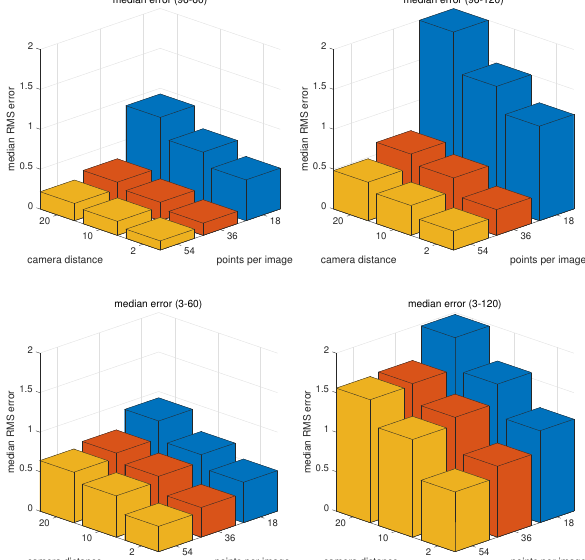
Figure 4. Median RMS error of AGPA as a function of cam- era distance d and number of tie-points visible in each image p . The error is in percentage with reference to points distributed on a unit sphere. Top row: Corresponding ray multiplicity values are [3 , 6 , 9] , where n = 96 . Bottom row: Corresponding total number of points are [96 , 192 , 288] , where the ray multiplicity is fixed to 3. Left/right column correspond to 60 ◦ / 120 ◦ field of view, respectively.